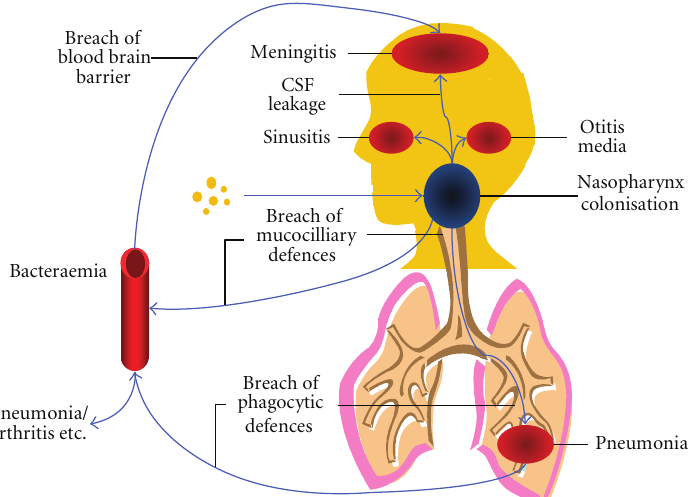
Figure 1: When pneumococci spread to the sinuses, ear, lung, and blood stream, diseases such as sinusitis, otitis media, pneumonia, and septicaemia can result. Invasion of the central nervous system (CNS) by colonising pneumococci follows an alteration in the balance between the virulence of the bacteria and the defences of the patient. Factors such as common colds or other upper respiratory virus infections alter the lining of the respiratory tract and allow bacteria to enter the bloodstream. Pneumococci then actively translocate across intact endothelial layers by means of specific receptor binding and translocation. Endothelial cells normally separate the blood from neuronal tissue forming a protective blood-brain barrier (BBB). The integrity of the BBB is compromised by apoptosis of endothelial cells. The BBB breakdown allows further invasion of cerebrospinal fluid